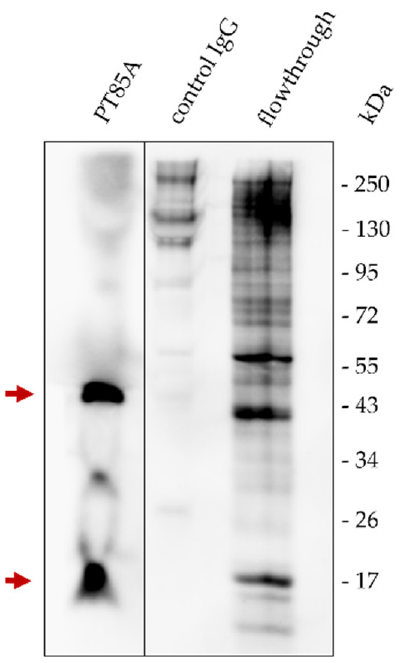
Figure 1. Western blot of isolated MHC-I molecules from porcine alveolar macrophages (PAMs). Cell surface proteins were immunoprecipitated with mAb PT85A linked to protein A/G magnetic beads. A mouse IgG2a isotype control was used to confirm the absence of isotype-specific binding. After running samples on a SDS-PAGE and blotting onto a nitrocellulose membrane, biotin was stained with avidin-HRP. The upper arrow indicates the MHC-I alpha chain at 45 kDa, which harbors the peptide binding groove, and the lower arrow β2-microglobulin at 12 kDa.